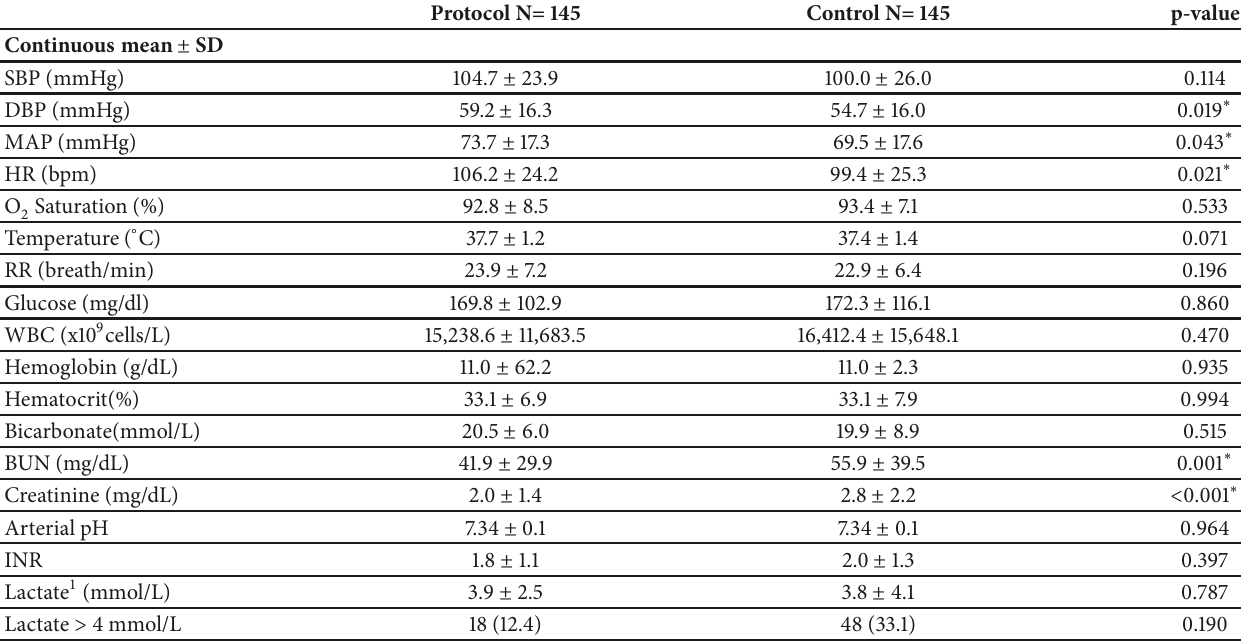
Table 2: Preresuscitation